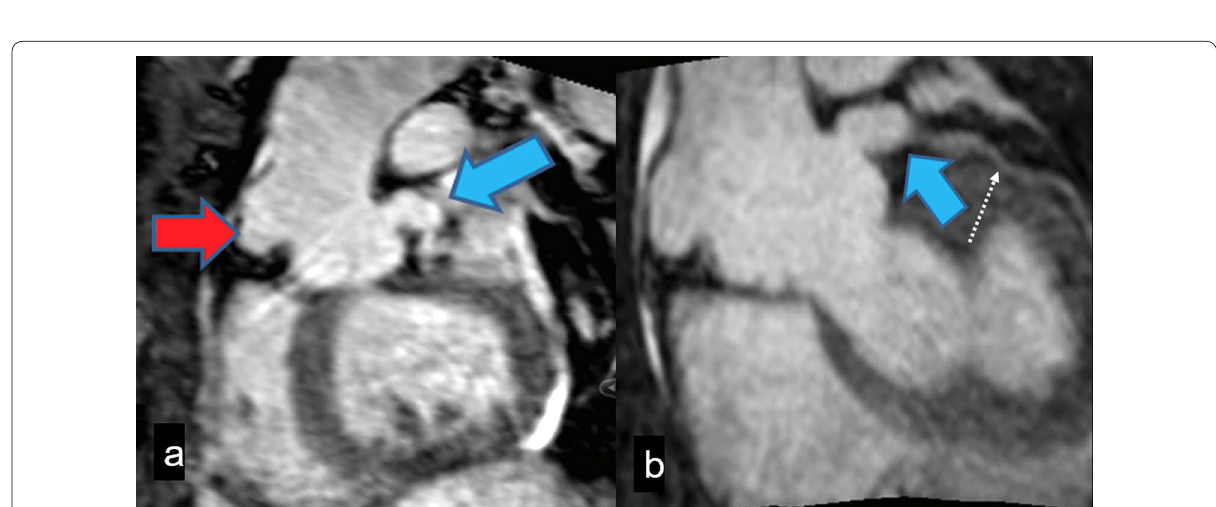
Fig. 2 a Cardiac triggered navigator-gated 3D bSSFP Noncontrast MR angiogram MIP image in parasagittal view showing aneurysmal dilation of right coronary ostium (red arrow) and fusiform aneurysmal dilation of Left main coronary artery (blue arrow). b MR angiogram in oblique coronal plane showing fusiform aneurysmal dilation of Left main coronary artery (blue arrow) followed by short segment total occlusion of proximal left anterior descending artery and diffusely narrow calibre distal vessel (dotted